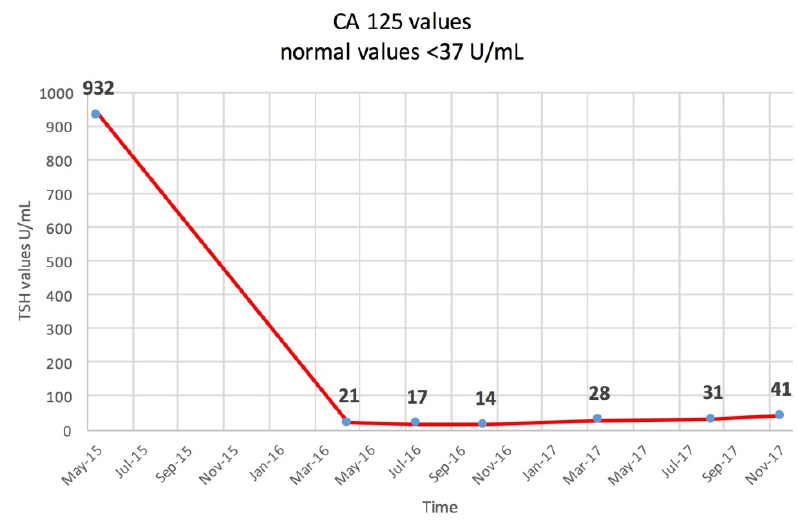
Figure 5. Serum CA 125 levels determined during the follow-up .